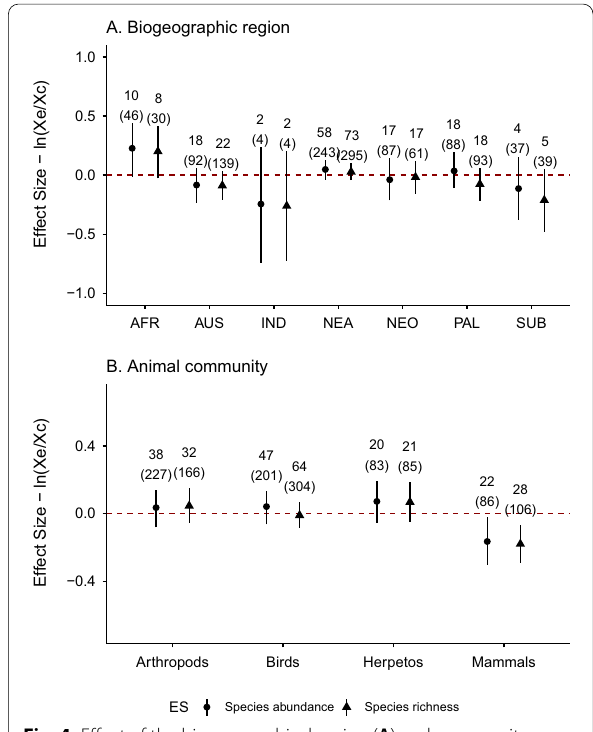
Fig. 4 Effect of the biogeographical region ( A ) and community type ( B ) on the richness and abundance of species. The circles represent the abundance of species, and the triangles the richness. The length of the lines represents the 95% confidence intervals. The numbers above dots represent the numbers of studies, and within parenthesis, the number of study pseudo‑replicas pooled to estimate the effect sizes. AFR Afrotropical, AUS Australian, IND Indomalaya, NEA Nearctic, NEO Neotropical, PAL Palearctic, SUB